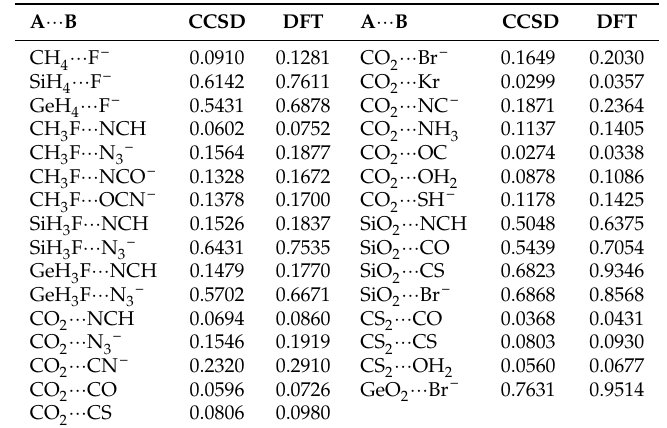
Table 2. CCSD and density functional theory (DFT) delocalization indexes, δ AB